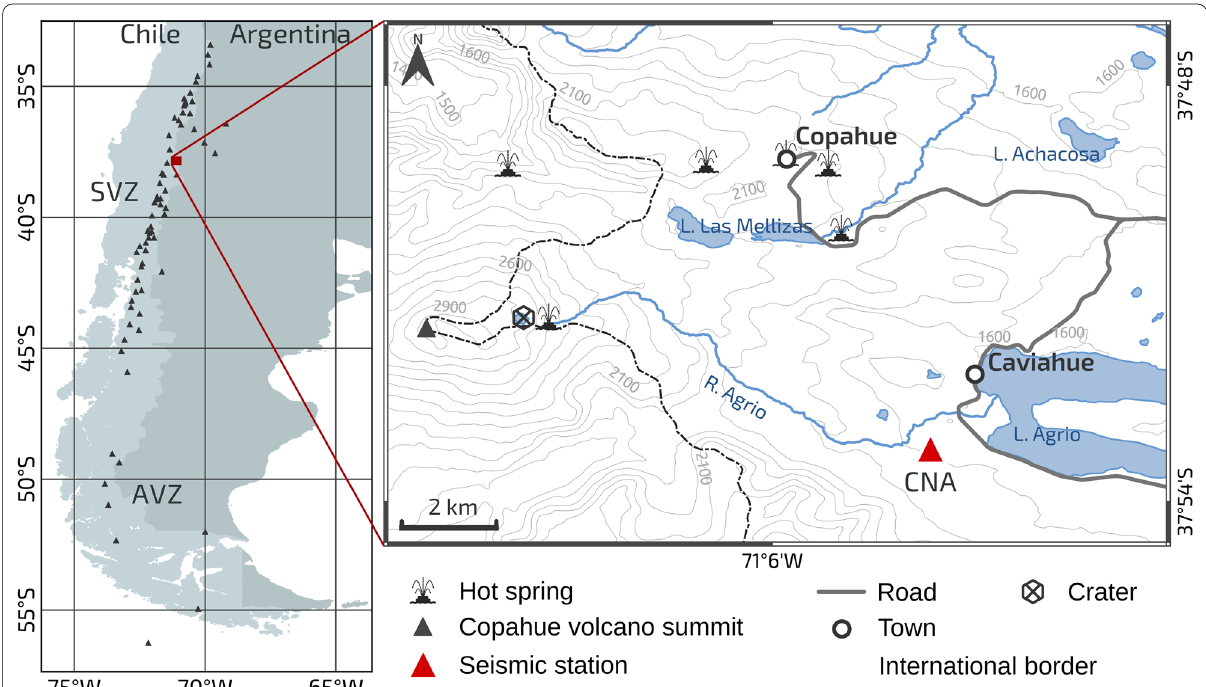
Fig. 1 Geotectonic setting for Copahue Volcano. At left, the geotectonic setting of Southern Volcanic Zone (SVZ) and Austral Volcanic Zone (AVZ). At right, the map locates the active crater, the seismic station (CNA), and the main geothermal